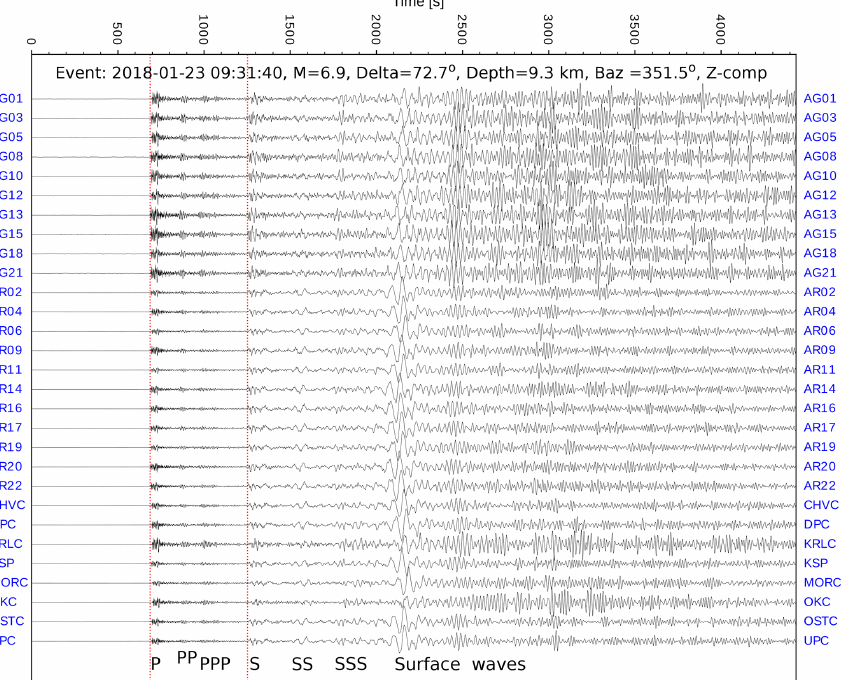
Figure 7. Example of vertical component of waveforms recorded for the M 6.9 teleseismic earthquake which occurred 23 January 2018 near Alaska (lat: 55.9315, long: − 149 . 1877, depth: 9.3km after ISC). Red lines mark the theoretical onsets of P and S phases at the KSP station. All seismograms are low-pass filtered ( <